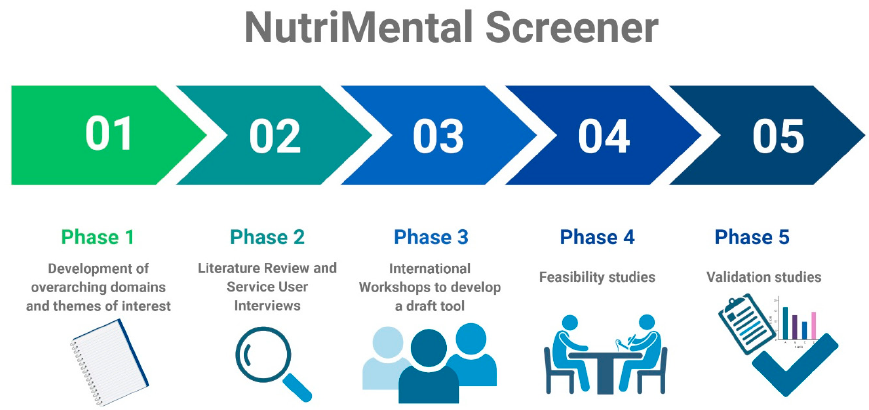
Figure 1. Development and validation phases of the NutriMental Screener tool. This figure was created with biorender.com (accessed on 7 October 2021).